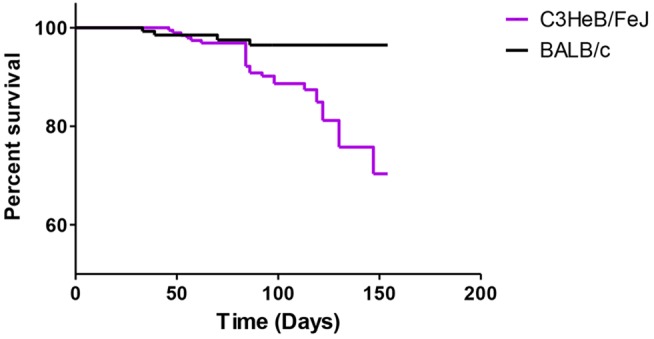
Aggregate survival of untreated and treated mice from the day of infection. Mice that were sacrificed at predetermined time points were censored. A higher rate of death was observed in C3HeB/FeJ mice compared with BALB/c mice.